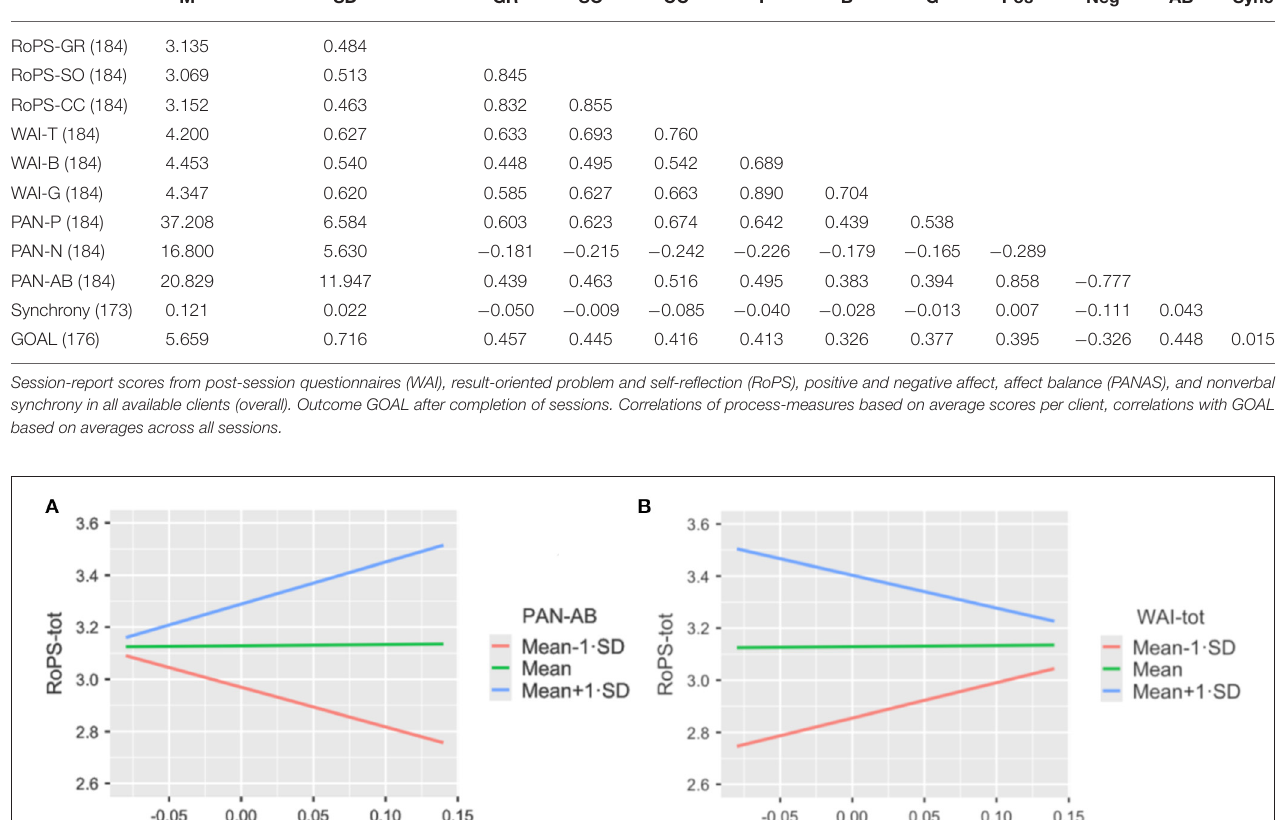
TABLE 2 | Session-report scores from post-session questionnaires. Sample ( N = 184) 64.1% female RoPS WAI